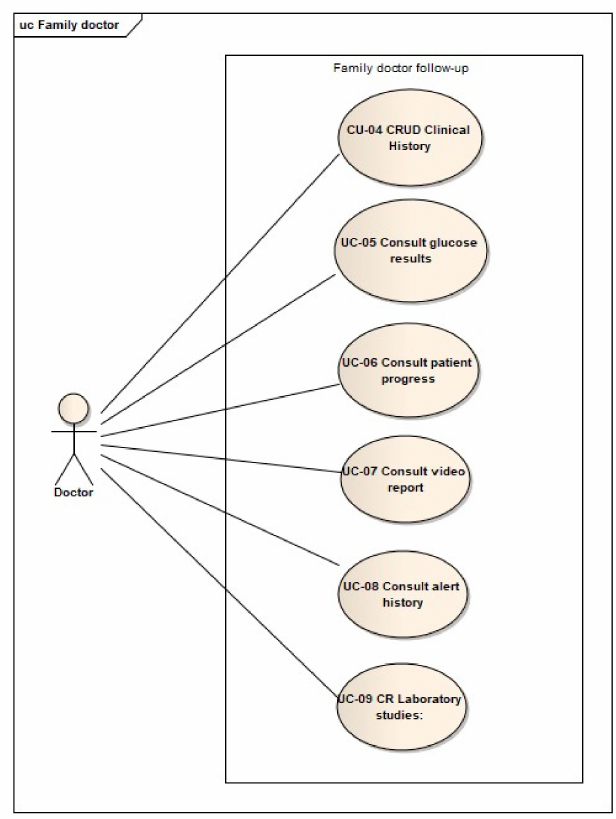
Figure 4. General physician follow-up UC